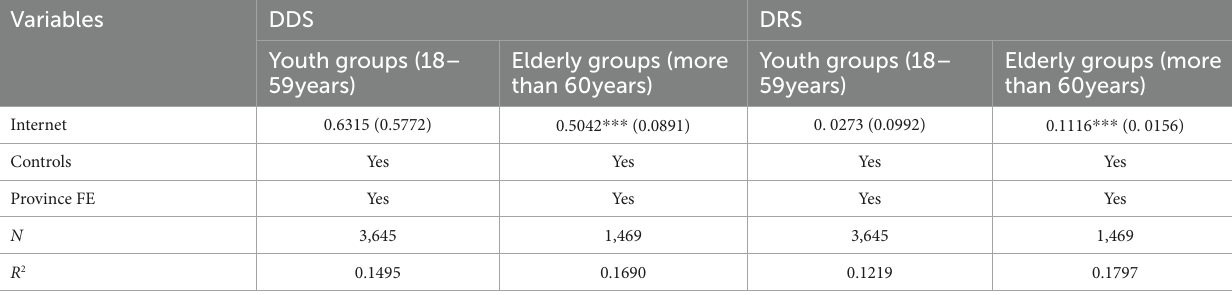
TABLE 7 Results of heterogeneity analysis on the relationship between the Internet and the age of household heads.